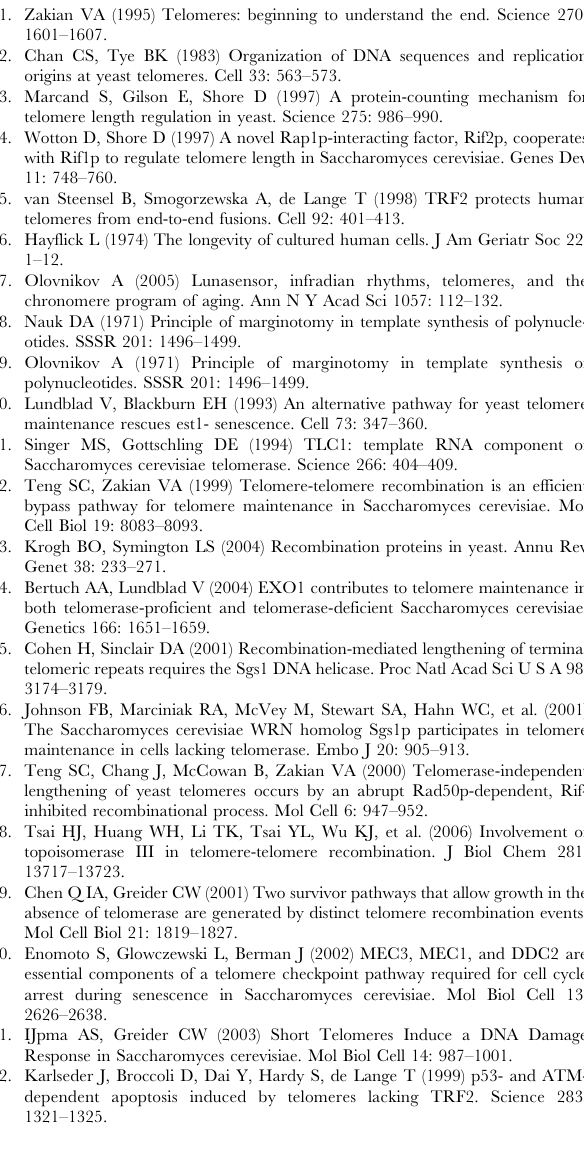
Figure S6 The distribution of Rad proteins in cells with short telomeres. Rad51 (red triangles) and Rad52 (blue ovals) are sequestered at chromosome ends in cells with short telomeres.